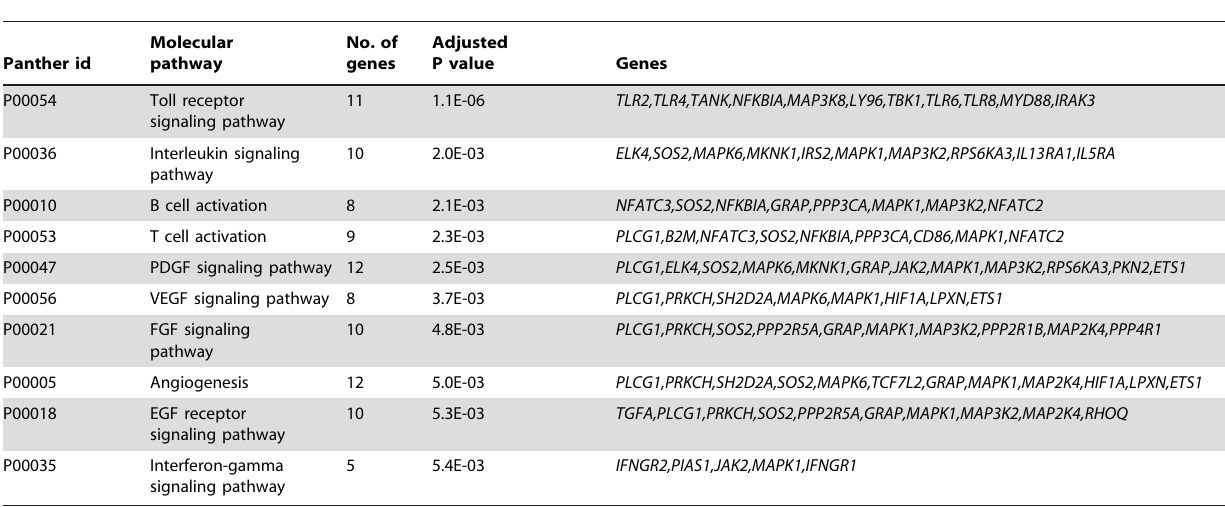
Table 2. The top ten molecular pathways enriched in the DEG list.